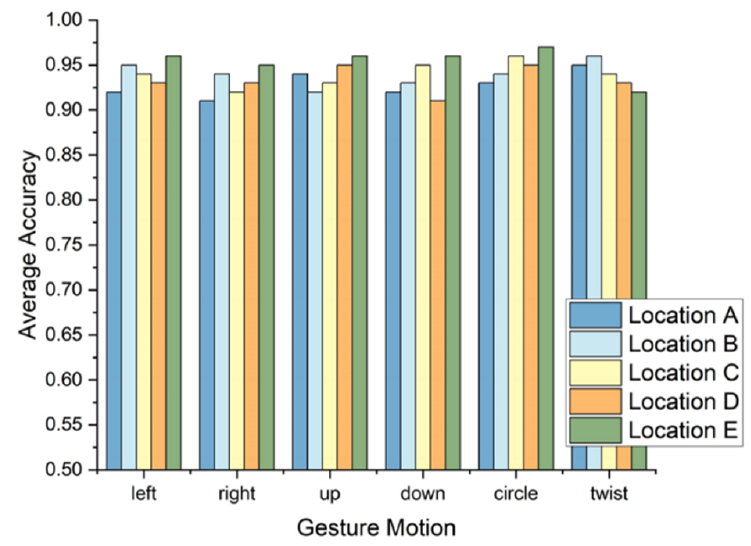
Figure 16. Influence of different location on recognition effect.